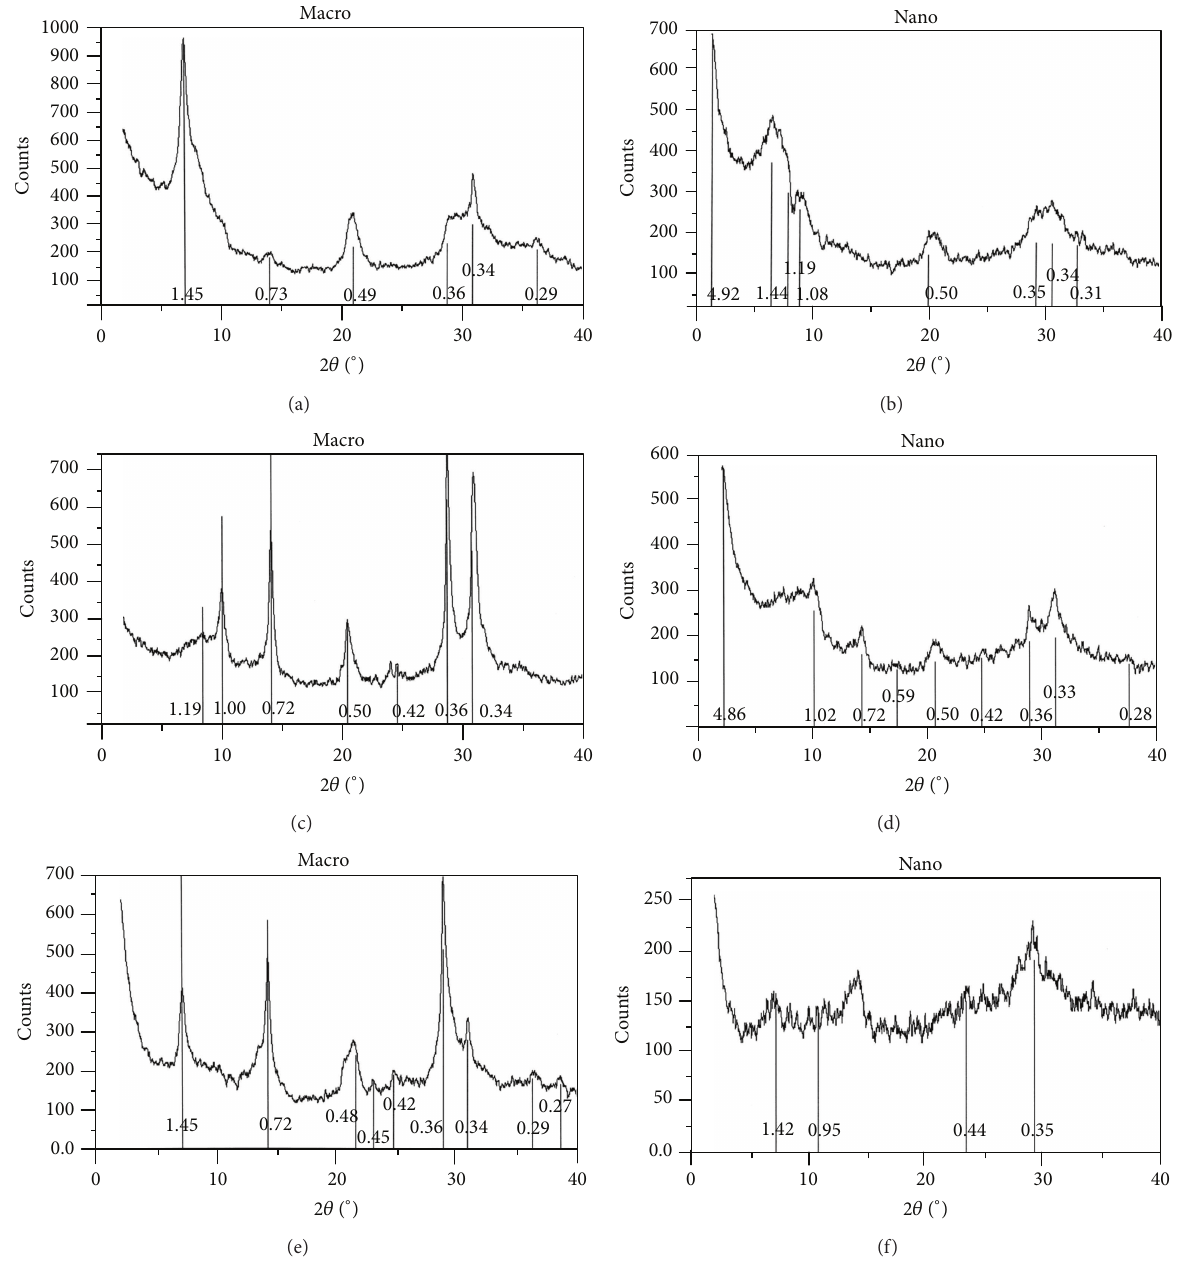
Figure 5: Mg-saturated XRD patterns of the (a) smectitic macro- and (b) nanocolloids, (c) mixed macro- and (d) nanocolloids, and the (e) kaolinitic macro- and (f)